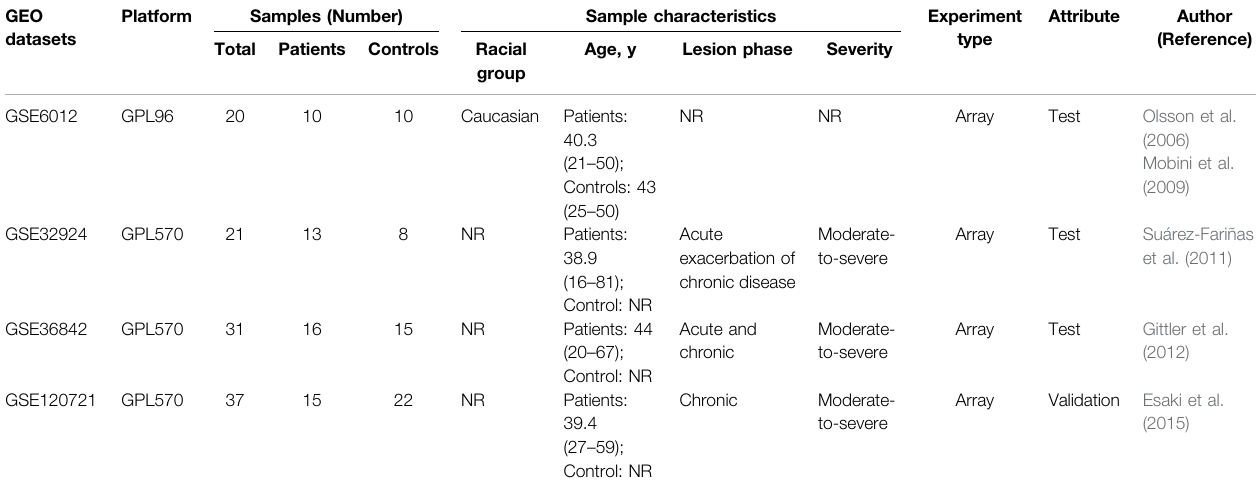
TABLE 1 | Baseline information regarding the selected datasets.